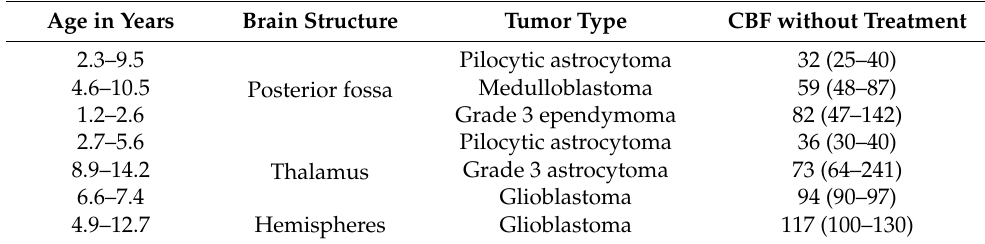
Table 5. Absolute CBF values (mL/100/min) according to age, brain structure, and tumor [57]. Imaging Technique: 3D Pseudo Continuous ASL MR Imaging on a GE Signa HDxt 1.5